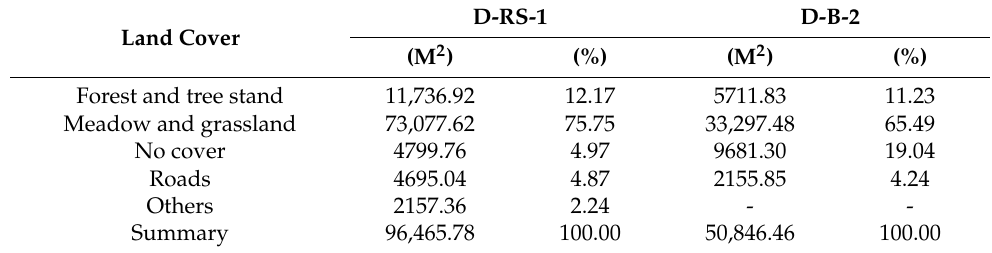
Figure 8. Plant cover on the coal-waste dump in D-RS-1 (11 June 2019): ( A ) a patch of Verbascum thapsus (see Figure 7—community IV), ( B ) Lepidium ruderale (Figure 7—F), ( C ) the zone with a fire surrounded by the community with Erigeron annuus (Figure 7—I), and ( D ) young specimens of Pinus sylvestris in the self-heating zone (Figure 7—VIII). Table 3. Share of the individual types of land cover (29 March